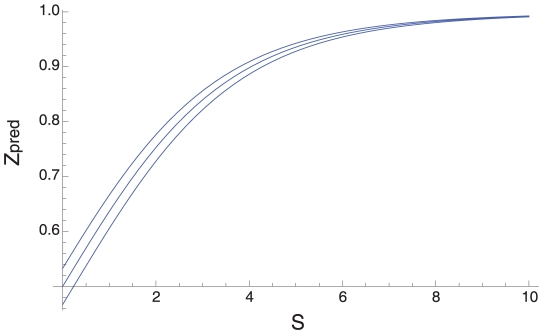
Selection on GC-content.The figure shows the effect of selection in favour of GC on Z. The relationship between Zpred and S (2Nes) for three values of f, the equilibrium GC-content when there is no selection (i.e. the mutation bias); from top to bottom f is 0.7, 0.5 and 0.3. In these examples 2Neμ = 0.1 and n = 10; qualitatively similar patterns are observed for other values of these two parameters.